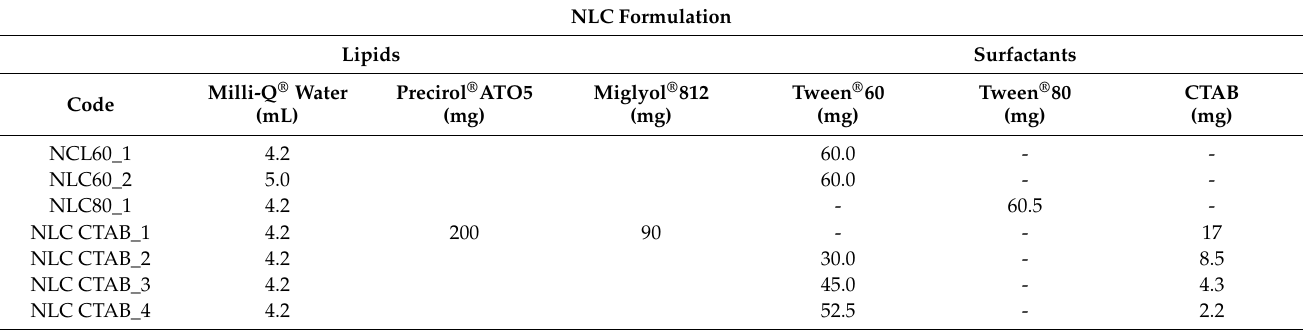
Table 1. Composition of the different nanostructured lipid carriers